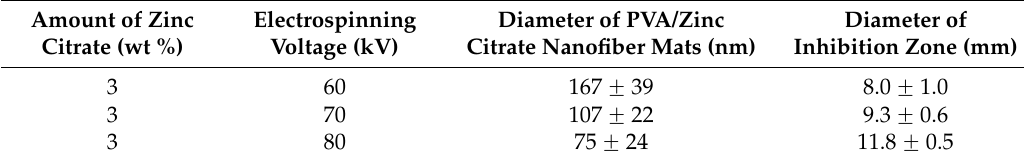
Table 4. Bacterial efficacy against S. aureus of PVA/zinc citrate nanofiber mats. Amount of